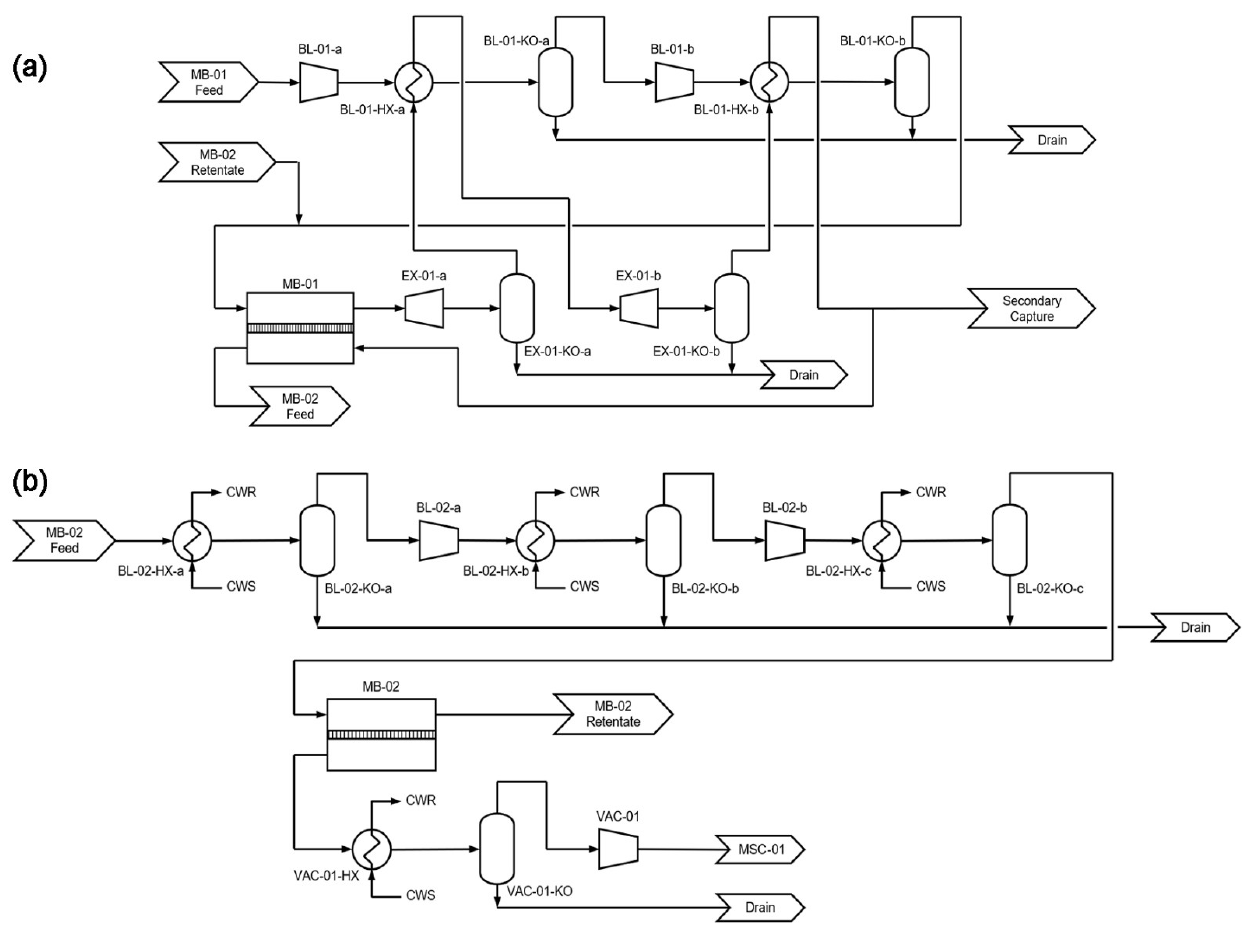
Figure 2. Detailed flow diagrams for the process equipment associated with ( a ) MB-01 for capture using the primary system only and ( b ) MB-02. Initialisms: cooling water supply (CWS), cooling water return (CWR), heat exchanger (EX), and knock-out vessel (KO).